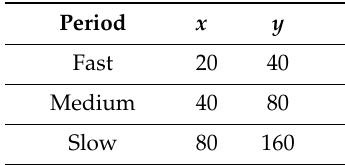
Table 1. Randomly selected